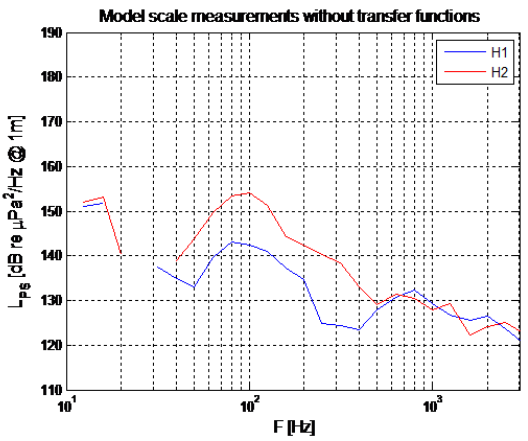
Figure 19: Cavitation tunnel noise prediction without considering transfer functions.